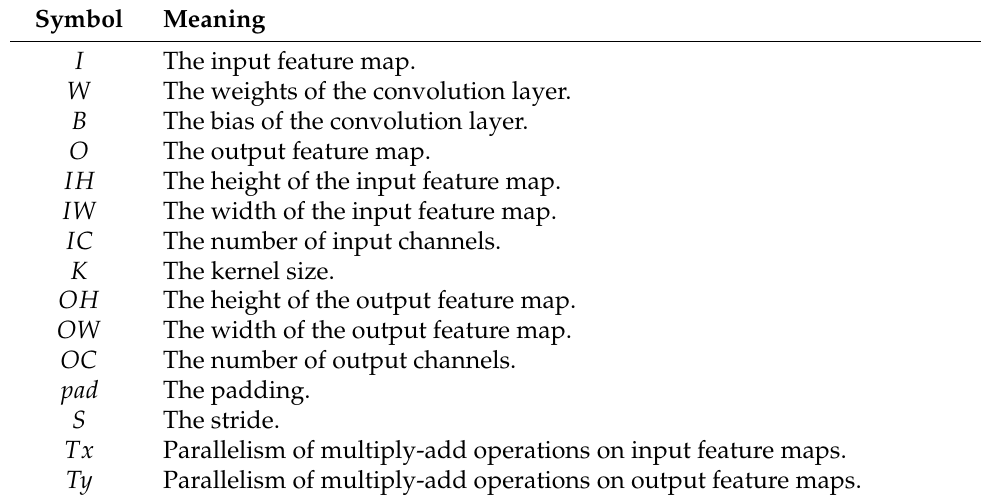
Table 2. Parameter conventions for convolution operations.